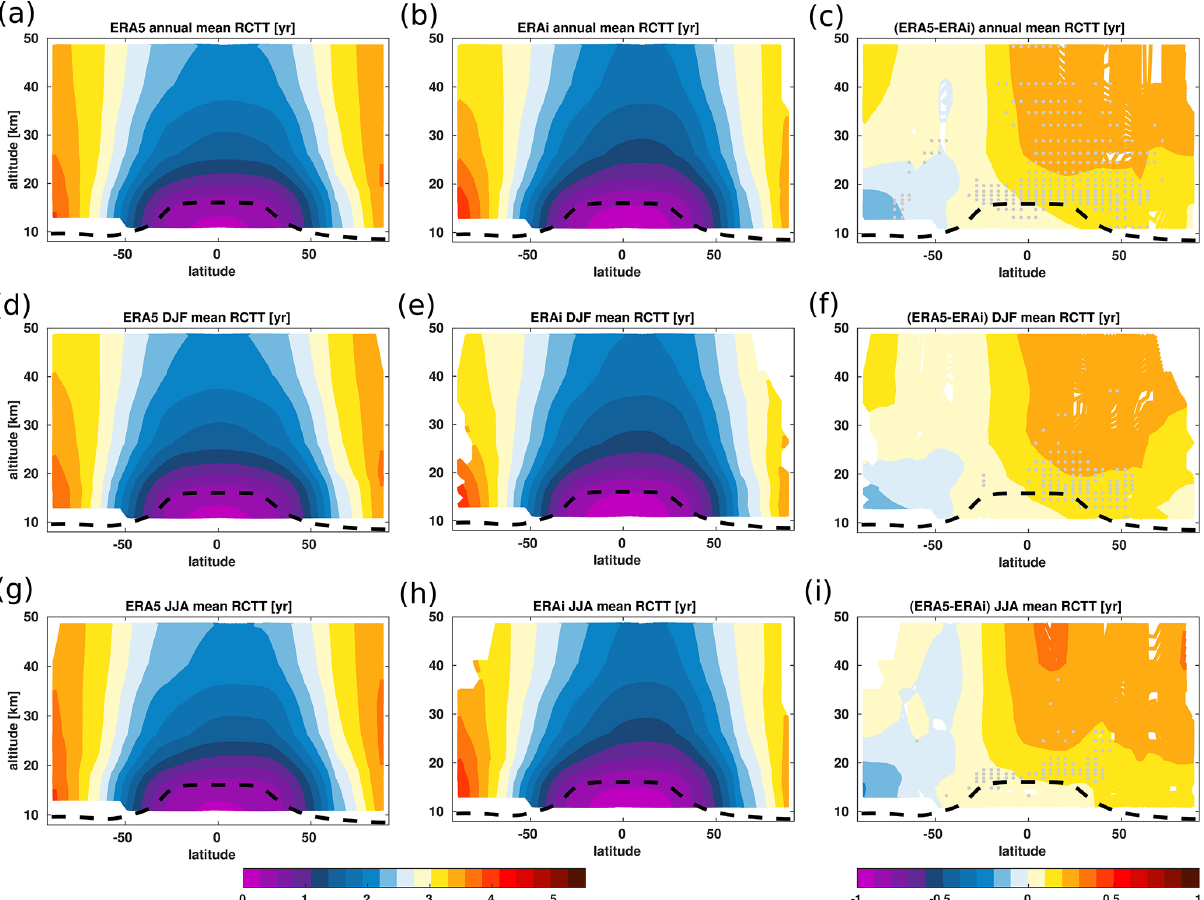
Figure 5. Zonal mean distribution of the annual (a, b) , DJF (d, e) , and JJA (g, h) mean variations of the residual circulation transit time (RCTT in yr) from the ERA5 (left column) and the ERA-Interim (middle column) reanalyses together with the associated differences (c, f, i) between the ERA5 and the ERA-Interim reanalyses (right column) for the 1979–2018 time period. Grey dots in panels (c, f, i) indicate regions where the differences between the ERA5 and ERA-Interim reanalyses are statistically significant at 95% estimated using Student’s t test. The climatological tropopause from the ERA-Interim is indicated as the dashed black horizontal